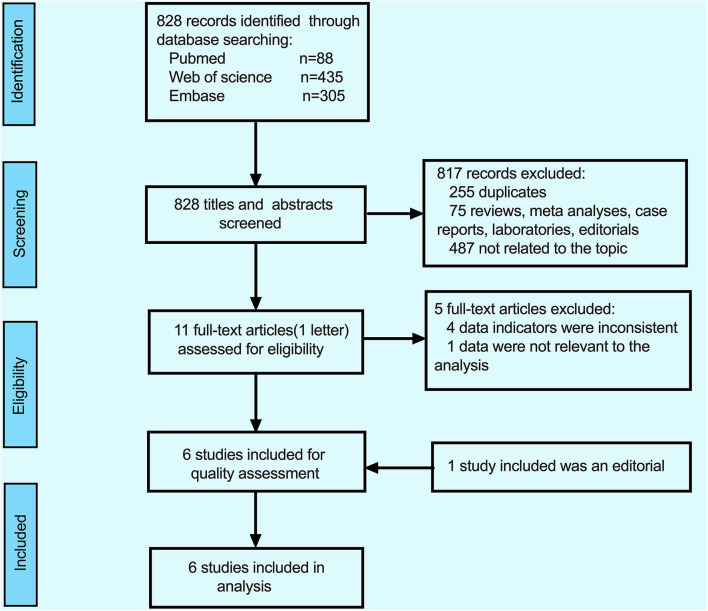
Flowchart of studies selection.